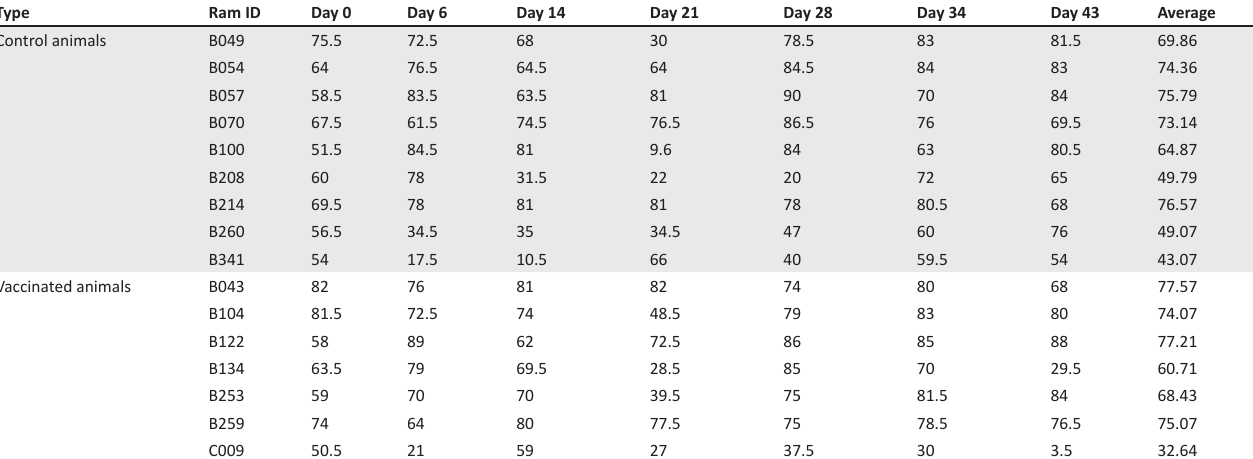
TABLE 3: Percentage progressively motile spermatozoa. Type